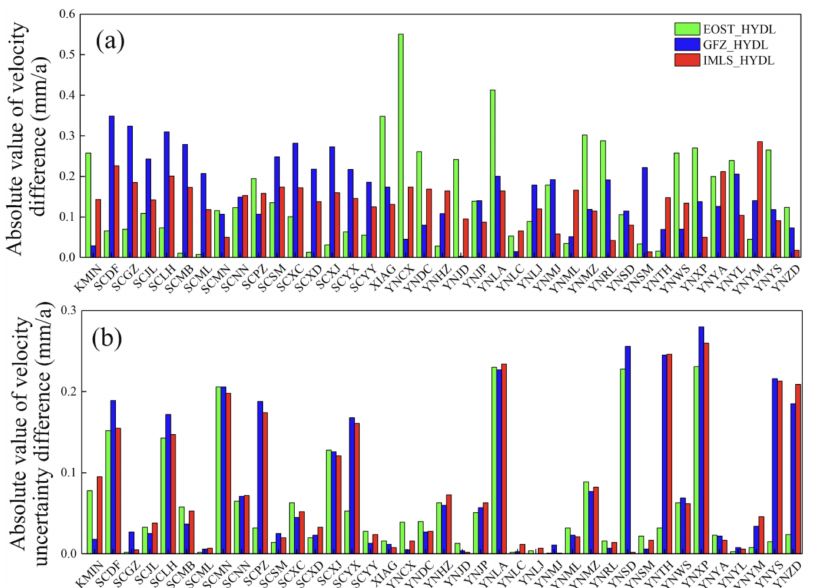
Figure 13. Absolute value of velocity and its uncertainty difference before and after HYDL correction for all stations in the Chuandian region: ( a ) represents the absolute value of velocity difference corrected by EOST_HYDL, GFZ_HYDL, and IMLS_HYDL; ( b ) represents the absolute value of velocity uncertainty difference corrected by EOST_HYDL, GFZ_HYDL, and